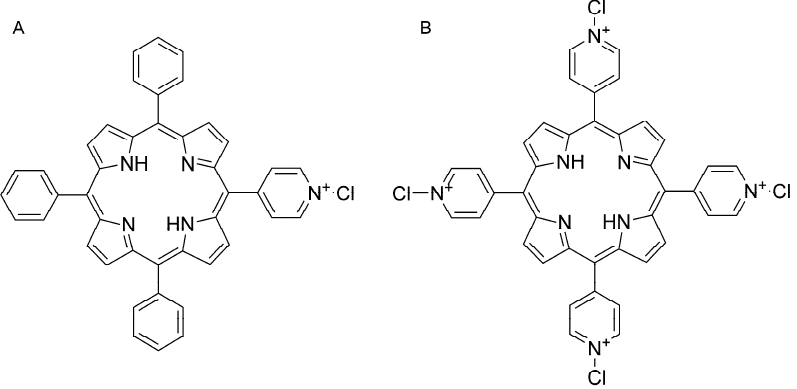
Figure 1. Schematic representation of the structure of the porphyrins ( A ) 5-( N -methyl 4-pyridyl)- 10,15,20-triphenyl porphine chloride (MMPyP) and ( B ) meso-tetra ( N -methyl 4-pyridyl) porphine tetrachloride (TMPyP).